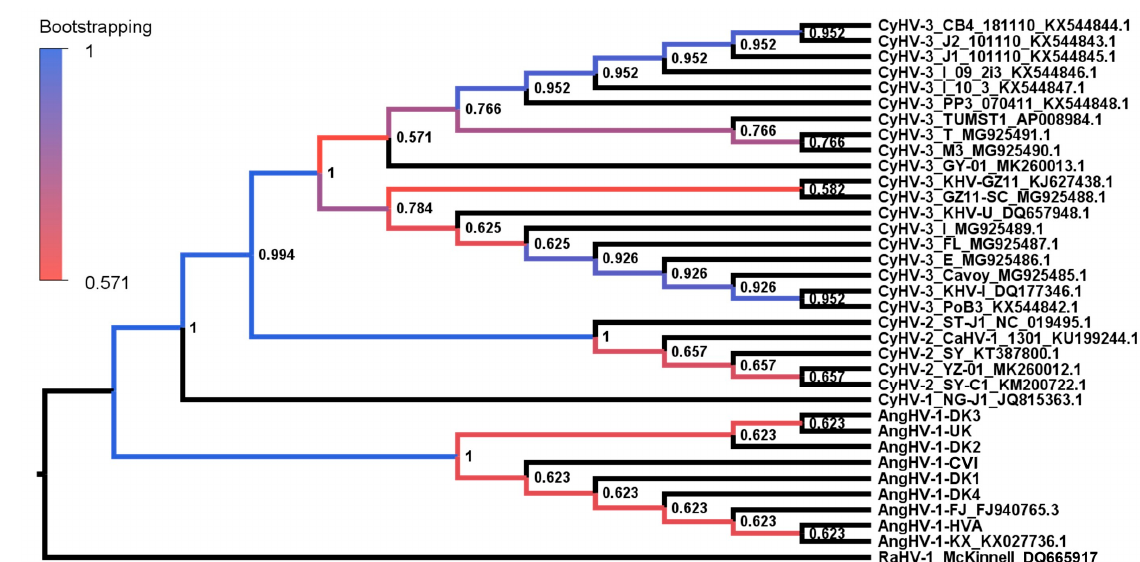
Figure 3. Phylogenetic analysis of concatenated cyprinivirus core gene sequences. Cladogram of bootstrap consensus tree (UPGMA) from phylogenetic analysis of concatenated AA sequences of three core genes (DNA polymerase, helicase and terminase) derived from sequenced cyprinivirus genomes. Bootstrap values (1000 replicates) are indicated at the right of each node. These values are also illustrated through the colors of the branches leading to each node, according to the scale on the top left. Branch lengths are arbitrary.